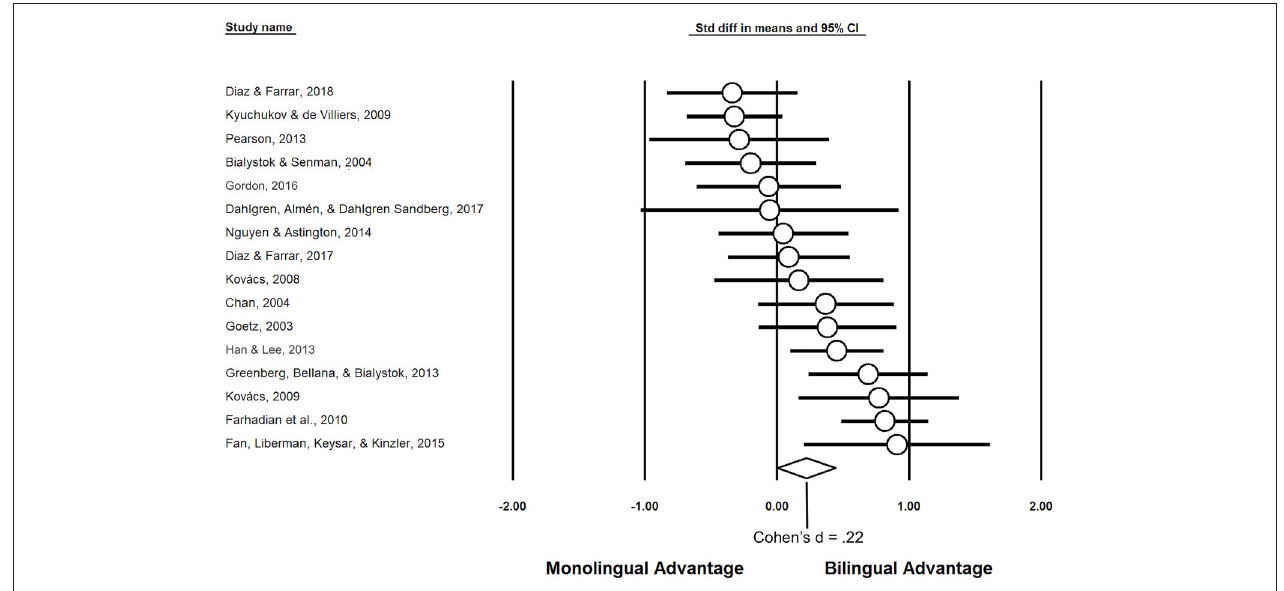
FIGURE 1 | A plot of effect sizes for each of the 16 studies in the main analysis, with the summary effect size of 0.22 at the bottom.